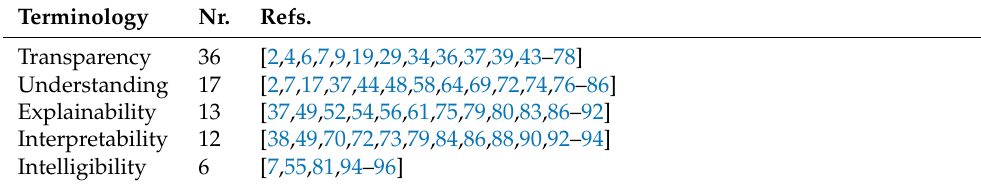
Table 1. Terminology used to describe the concept of transparent